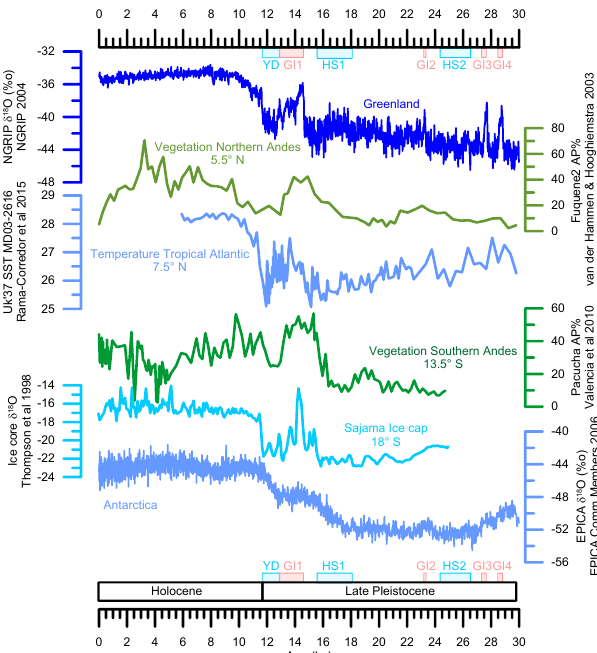
Figure 5. Millennial-scale vegetation changes in the northern and southern tropical Andes over the past 30ka compared with other records: north Greenland (NGRIP Members, 2004), EPICA Dome C (EPICA, 2006), and Sajama ice core record (Thompson et al., 1998), as well as sea surface temperatures (SST) from the Guyana Basin in the tropical Atlantic (Rama-Corredor et al., 2015). Hein- rich stadials (HS) are drawn for reference as defined by Sánchez- Goñi and Harrison (2010). The Younger Dryas (YD) follows the timing of Greenland stadial 1 (Rasmussen et al., 2006) and the chronozone defined by Mangerud et al. (1974). The timing of Greenland interstadials (GI) is based on Wolff et al.